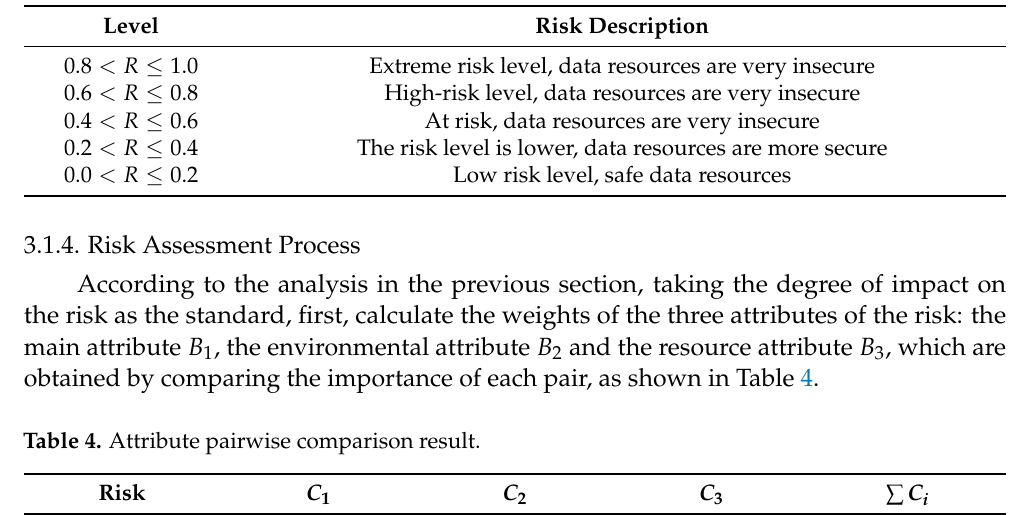
Table 3. Request risk membership level.